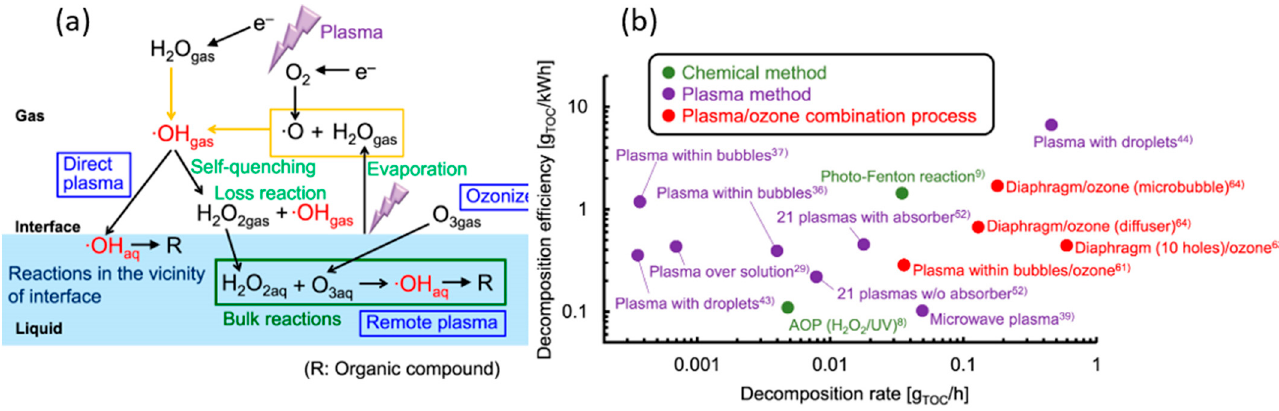
Figure 5. ( a ) Graphical representation of main reactions involves in the breakdown of organic compound using oxygen plasma in plasma–liquid interface. ( b ) Comparison between the breakdown rates and efficiencies of organic compound with several methods. (Figure a and b are reprinted from [76]).